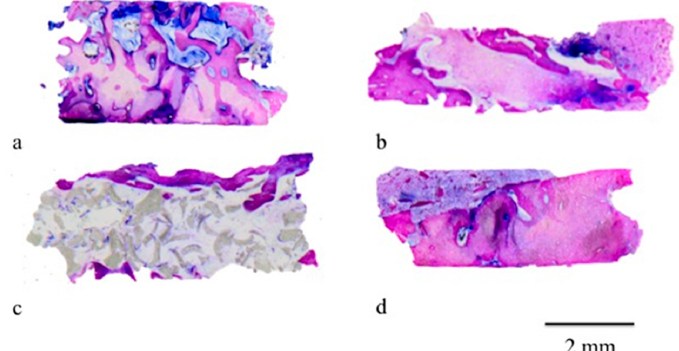
Figure 5. The sections of the harvested biopsies: Calcium sulphate plus nanohydroxyapatite (CS + NHA) groups ( a ); calcium sulphate (CS) groups ( b ); nanohydroxyapatite (NHA) group ( c ); control group ( d ). Original magnification 12 × .